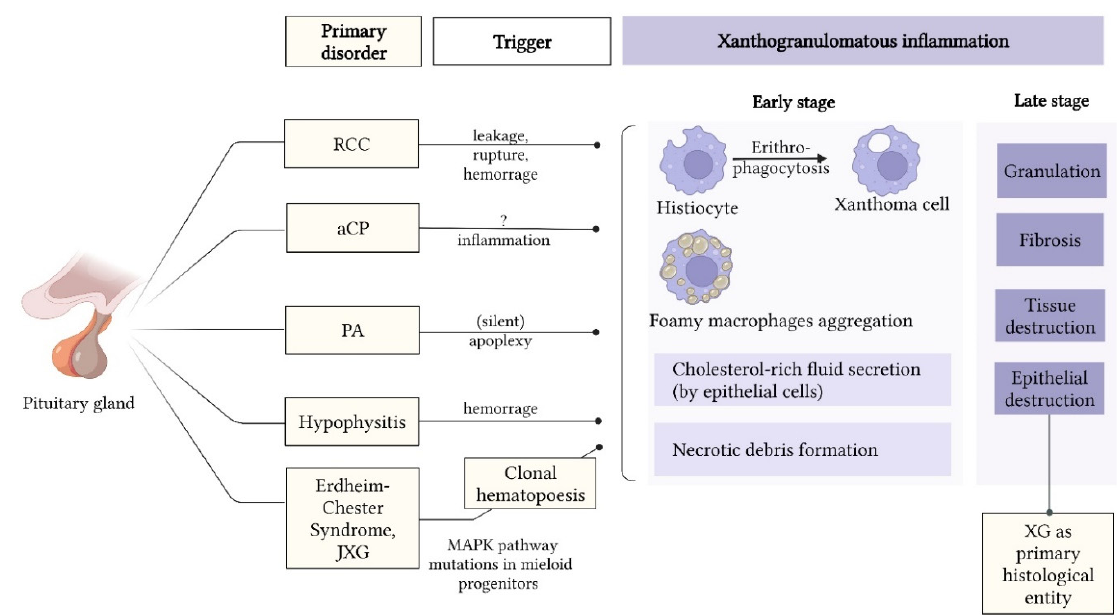
Figure 2. Theories explaining the etiopathology of sellar XG. Abbreviations: aCP = adamantinomatous craniopharyngioma; CP = craniopharyngioma; JXG = juvenile xanthogranuloma; MAPK = mitogen-activated protein kinase; PA = pituitary adenoma; RCC = Rathke’s cleft cyst; XG =